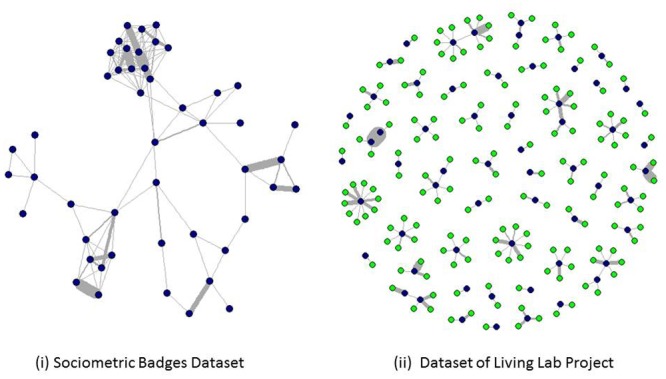
Sample daily networks of the two datasets.(i) The network of the community of participants is constructed based on the sociometric badges dataset in one typical day. The infrared sensors can only detect the infrared sensors of other participants, so the network includes face-to-face interactions within the community of participants. (ii) The call network is constructed including people within or outside the participant community in one typical day. MTL participants are coloured with dark blue while non-participants are coloured with green. In both networks, the thickness of edges represents the intensities of communication between two nodes. We can see that individuals are inclined to divide their time unequally among their social contacts.